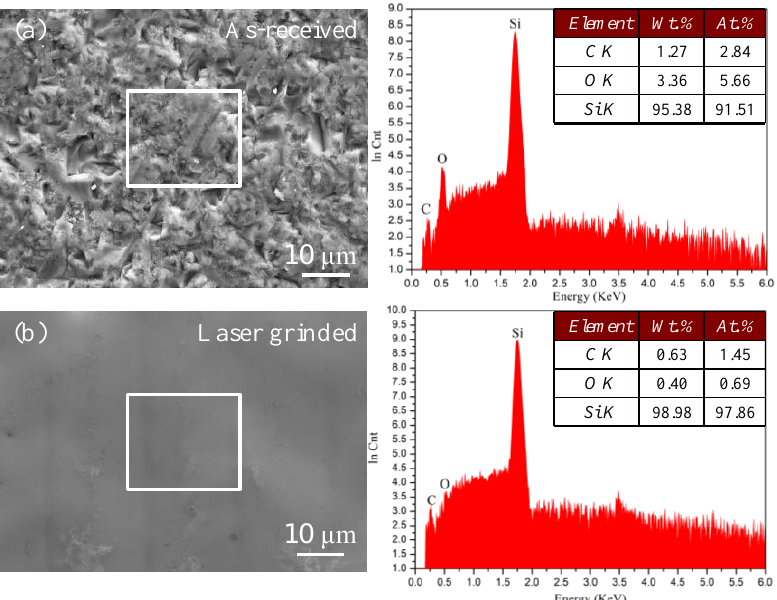
Figure 4. Elemental distribution and chemical composition ( Wt . %/ At . %) correspond to the white box in SEM from EDS spectrum analysis.